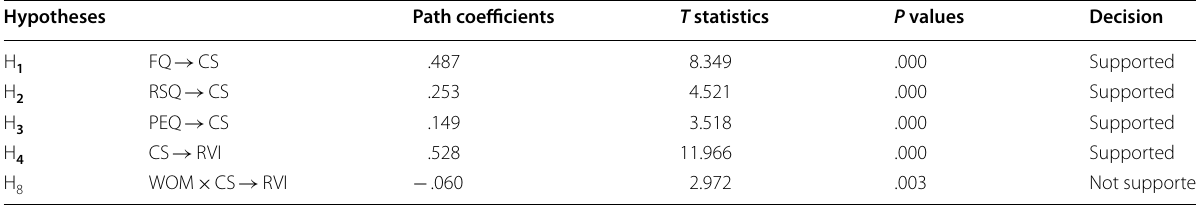
Table 4 Results of hypotheses with path